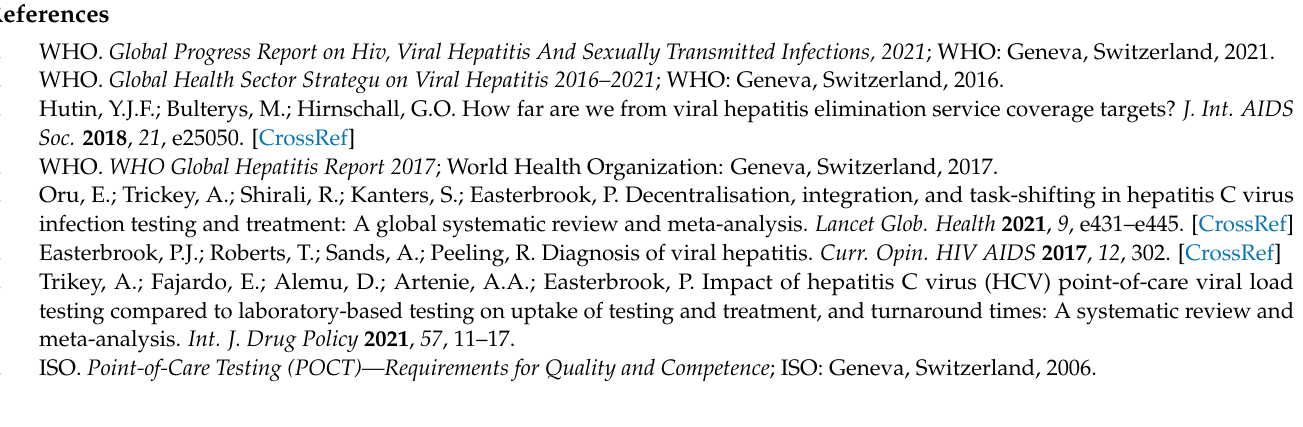
Figure S2: Deek’s Funnel plot with superimposed regression line; Table S1: PRISMA-P 2015 CHECK- LIST; Table S2: Database search strategy (Terms and synonyms); Table S3: Basic characteristics of evaluated POC viral load assays; Table S4: Summary of study characteristics and diagnostic accuracy of HCV Point-of-care testing assays from 25 studies; Table S5: Quality assessment of diagnostic accuracy studies of HCV viral load testing using the GRADE